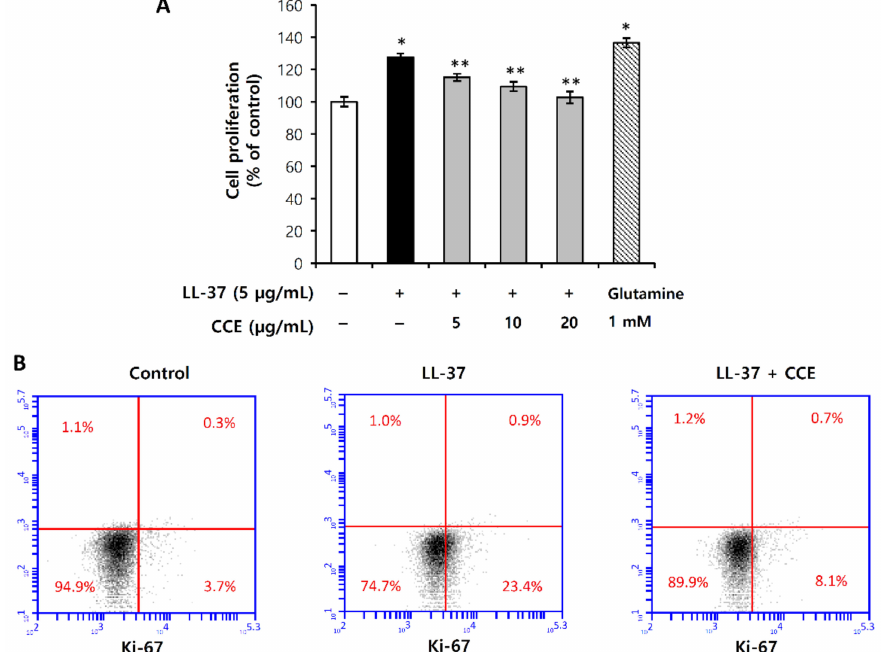
Figure 7. CCE inhibits HMEC-1 proliferation induced by LL-37. ( A ) HMEC-1 was pretreated with 5, 10, or 20 µ g / mL CCE and 1 mM L-glutamine for 1 h, and then further incubated with 5 µ g / mL LL-37 for 72 h. HMEC-1 proliferation was then determined by WST assay. ( B ) HMEC-1 was pretreated with 20 µ g / mL CCE for 1 h, and then further incubated with 5 µ g / mL LL-37 for 48 h. Cells were harvested, and stained with monoclonal Ki-67-FITC antibody and Rat IgG2a kappa Isotype Control-FITC. Ki-67 expression was analyzed by flow cytometry. The results are mean ± standard deviation (SD) ( n = 3). * p < 0.01 vs. LL-37-untreated control; ** p < 0.05 vs. LL-37-treated